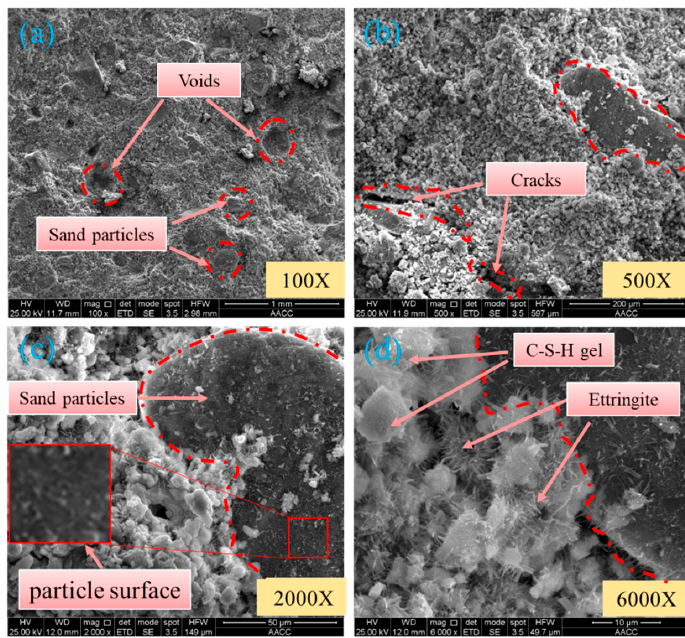
Figure 13. SEM micrographs of microstructure inside filled object for a curing time of 3 days under various magnifications (as indicated at the bottom right-hand corners): ( a ) filled object at 100x magnification ; ( b ) filled object at 500x magnification ; ( c ) filled object at 2000x magnification ; ( d ) filled object at 6000x magnification .